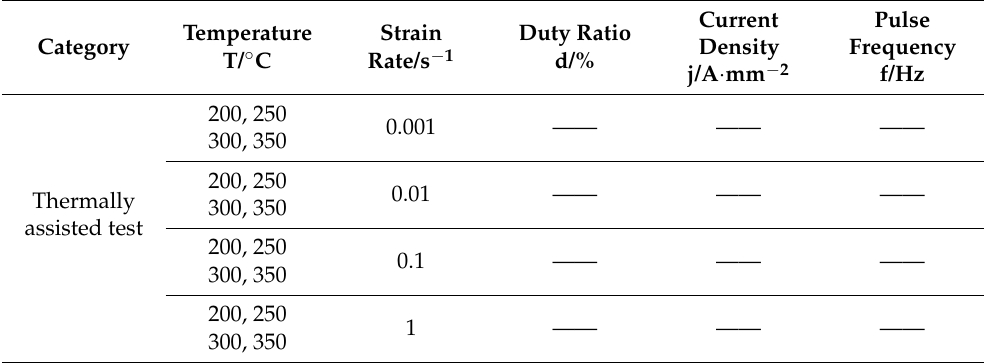
Figure 1. ( a ) OM image and ( b ) XRD pattern of the Mg 98.5 Zn 0.5 Y 1 alloy. Table 2. Experimental variables and conditions of the uniaxial tensile